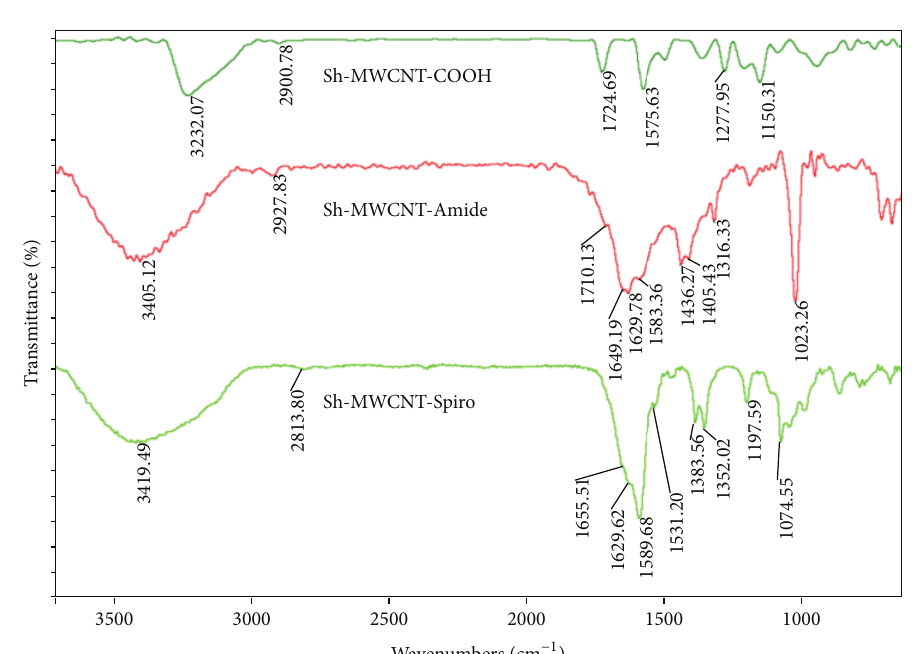
Figure 2: FT-IR spectra (after baseline correction) of modified-MWCNTs.